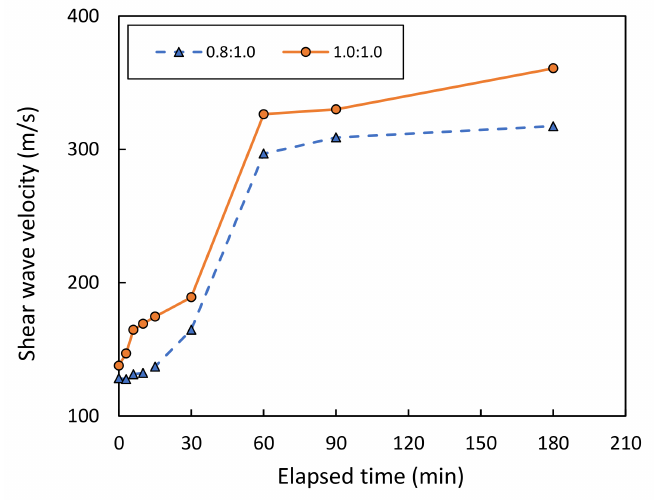
Figure 12. Shear wave velocity vs. the elapsed time of bender element testing for metakaolin treated at 1000 ◦ C, using different mixing ratios.